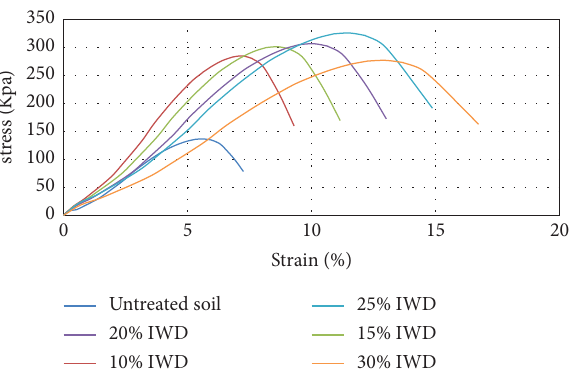
Figure 8: Efect of waste incineration bottom ash variation and 7-day curing time on weak subgrade